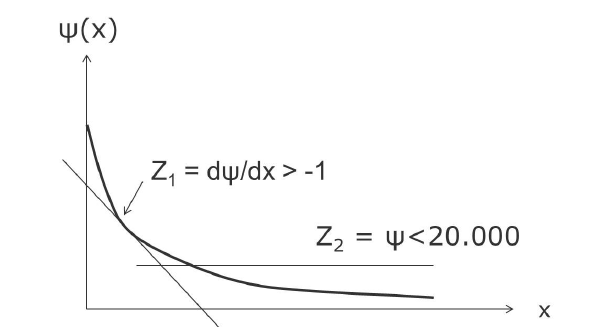
Figure 11: Examples of examination stop criteria Z 1 and Z 2 , where Z 1 dictates a stop when the marginal value of verification risk ( ∂ Ψ /∂x ) reduction is lower than the marginal exam- ination effort ∂x , and Z 2 dictates a stop when the overall verification risk is below the value 20 . 000.